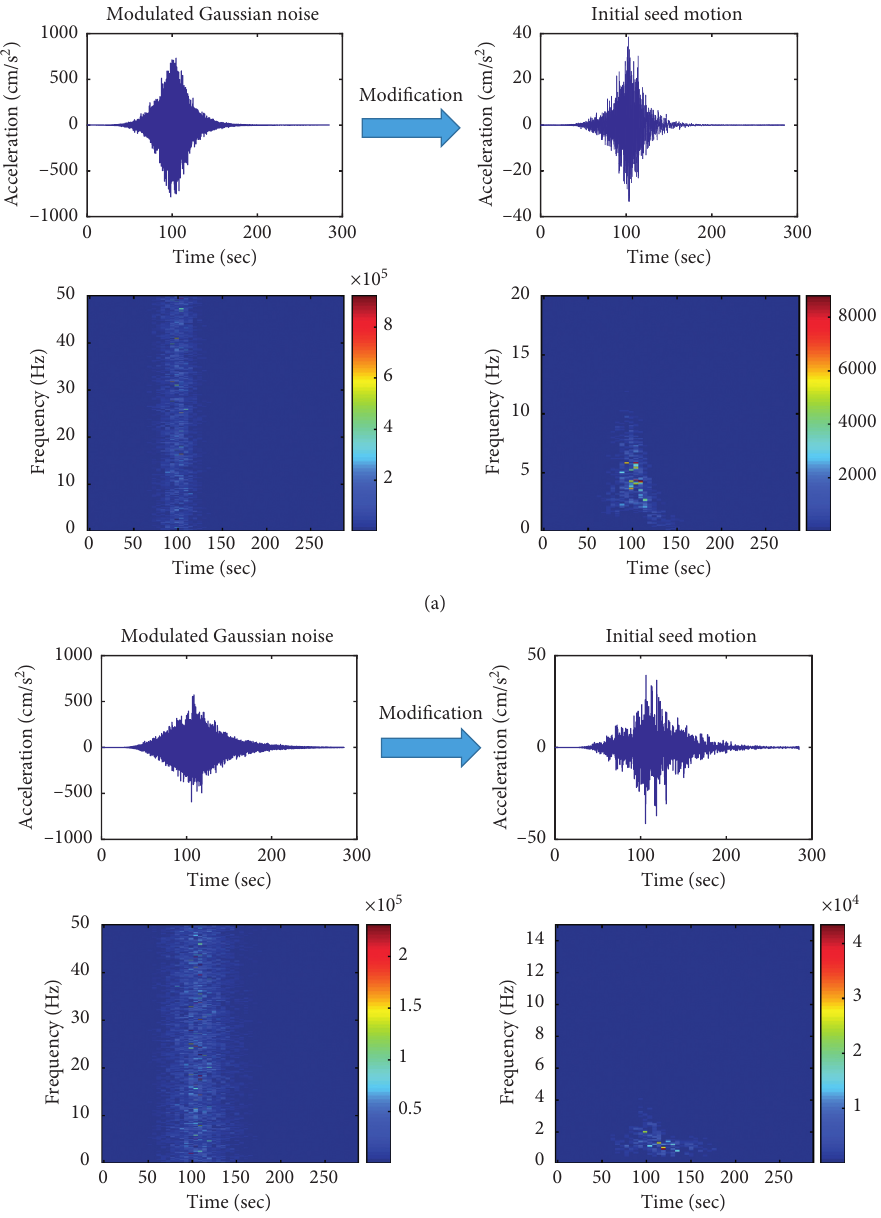
Figure 14: Illustration of changes in the initial seed motions considering the time-frequency domain. (a) CHB002EW and (b) As suggested by the limitation of wavelet packets, there is low resolution at long periods. This means that the proce- dure cannot attain adequate accuracy during long periods ranging from 5 to 10 sec. Because of this, the frequency range in this process is defined within [0.3, 25 Hz], during which wavelet packets take advantage of high resolution to make simulations compatible with the targeted spectrum as ac- curately as possible.